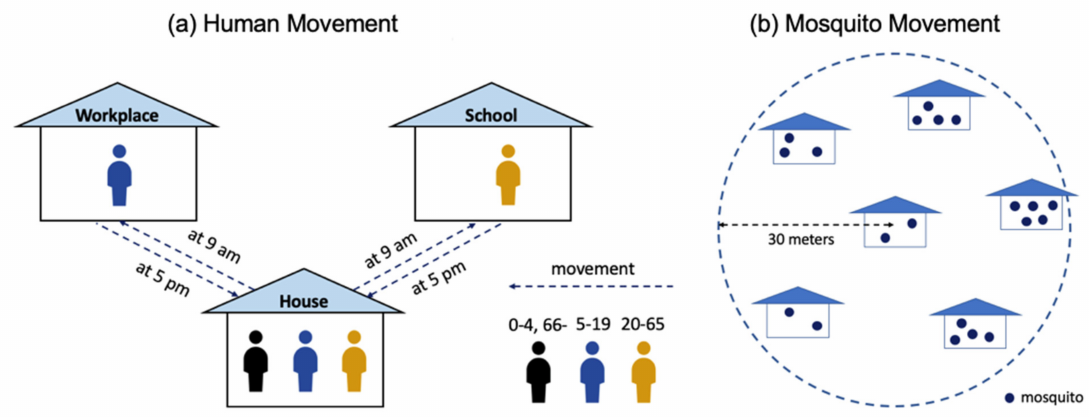
Figure 4. Agent movements. ( a ) Human movement; ( b ) Mosquito